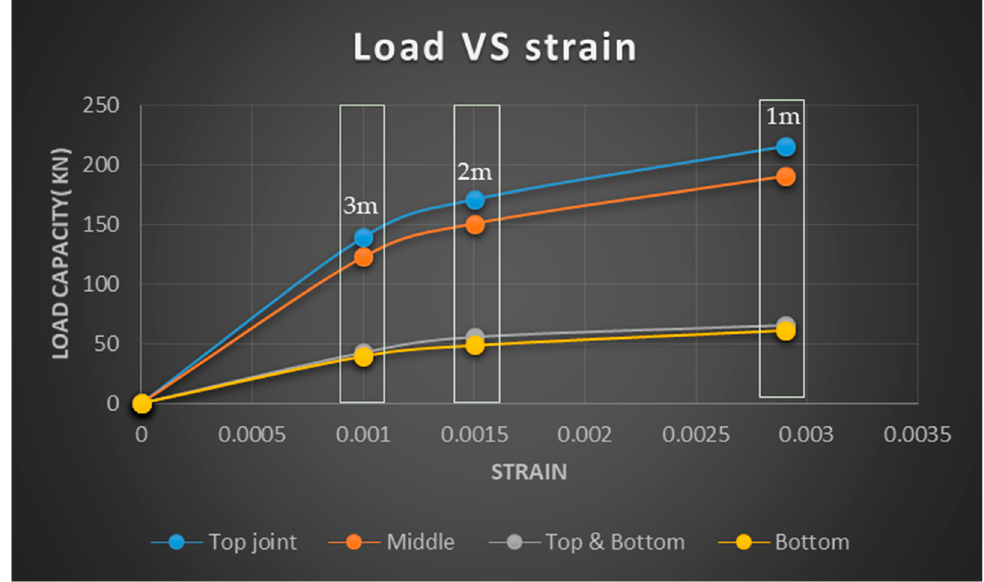
Figure 14. Comparison of capacity load of TDGLC + TG.